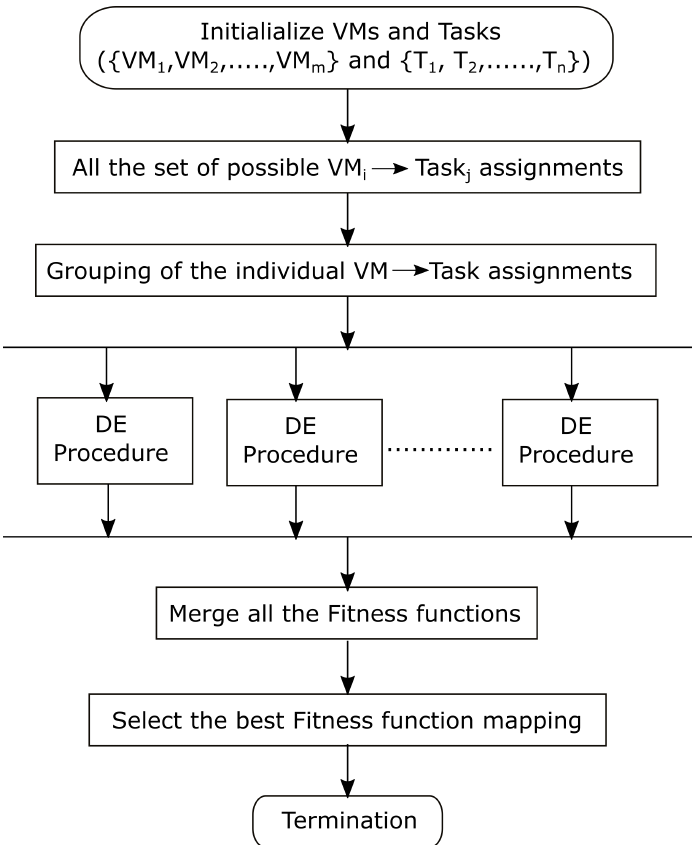
Figure 11. Parallel differential evolution process.